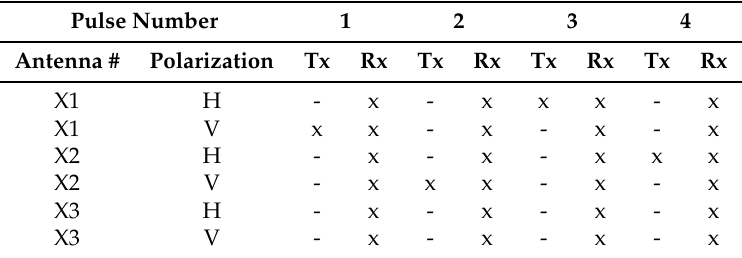
Table 2. Pulse sequence for the simultaneous dual-baseline Pol-InSAR XTI and half-baseline ATI mode: active antennas and operation sequence for the 2017 interferometry tests.